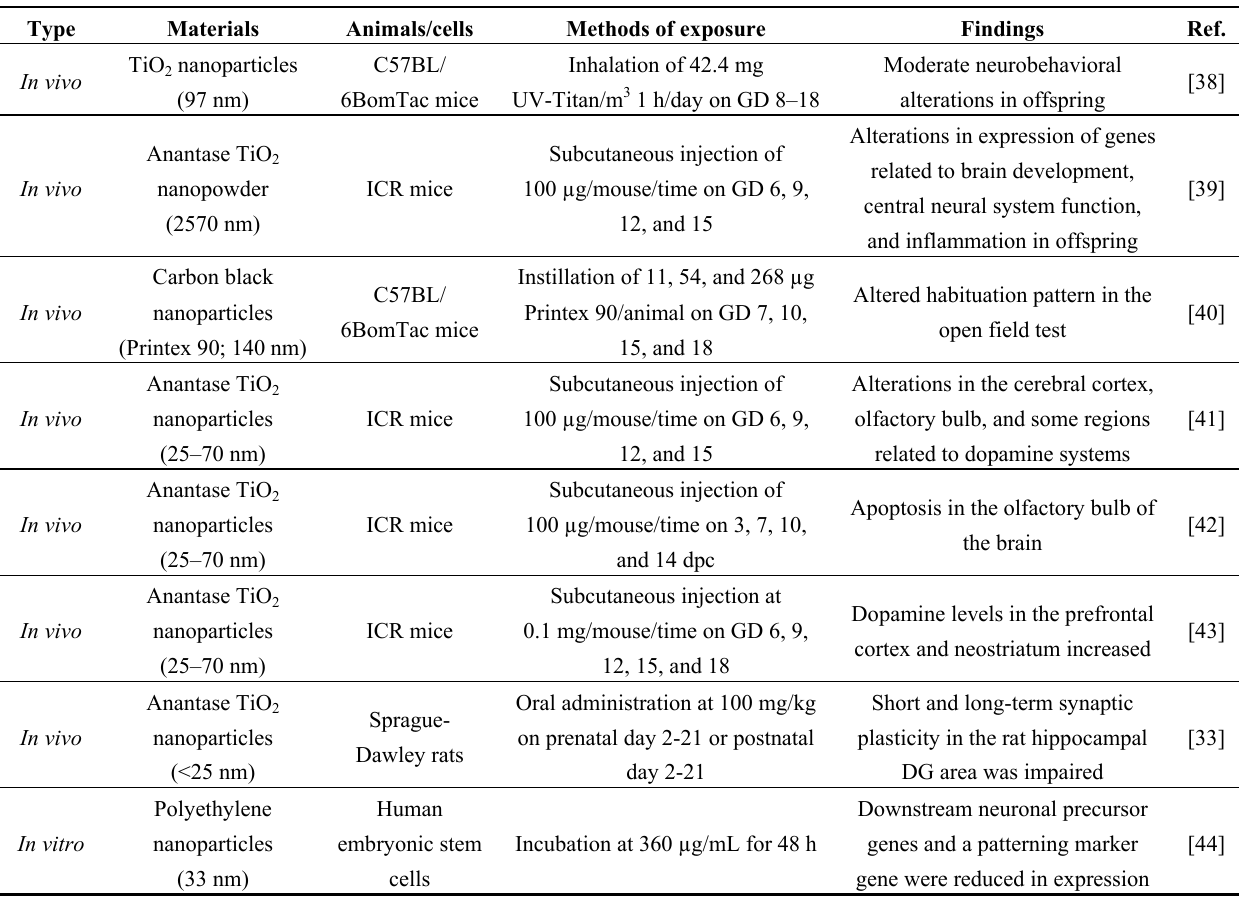
Table 3. Neurotoxicity of nanoparticles to offspring.